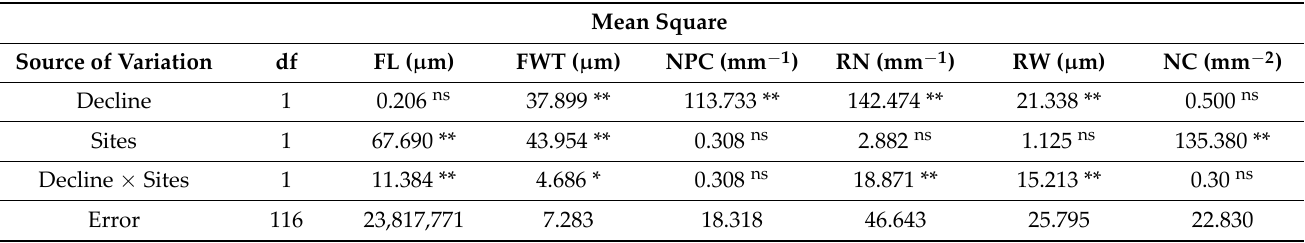
Table 1. Summary of two‑way ANOVA of wood anatomical variables in sapwood of healthy and declined Quercus brantii affected by drought stress.